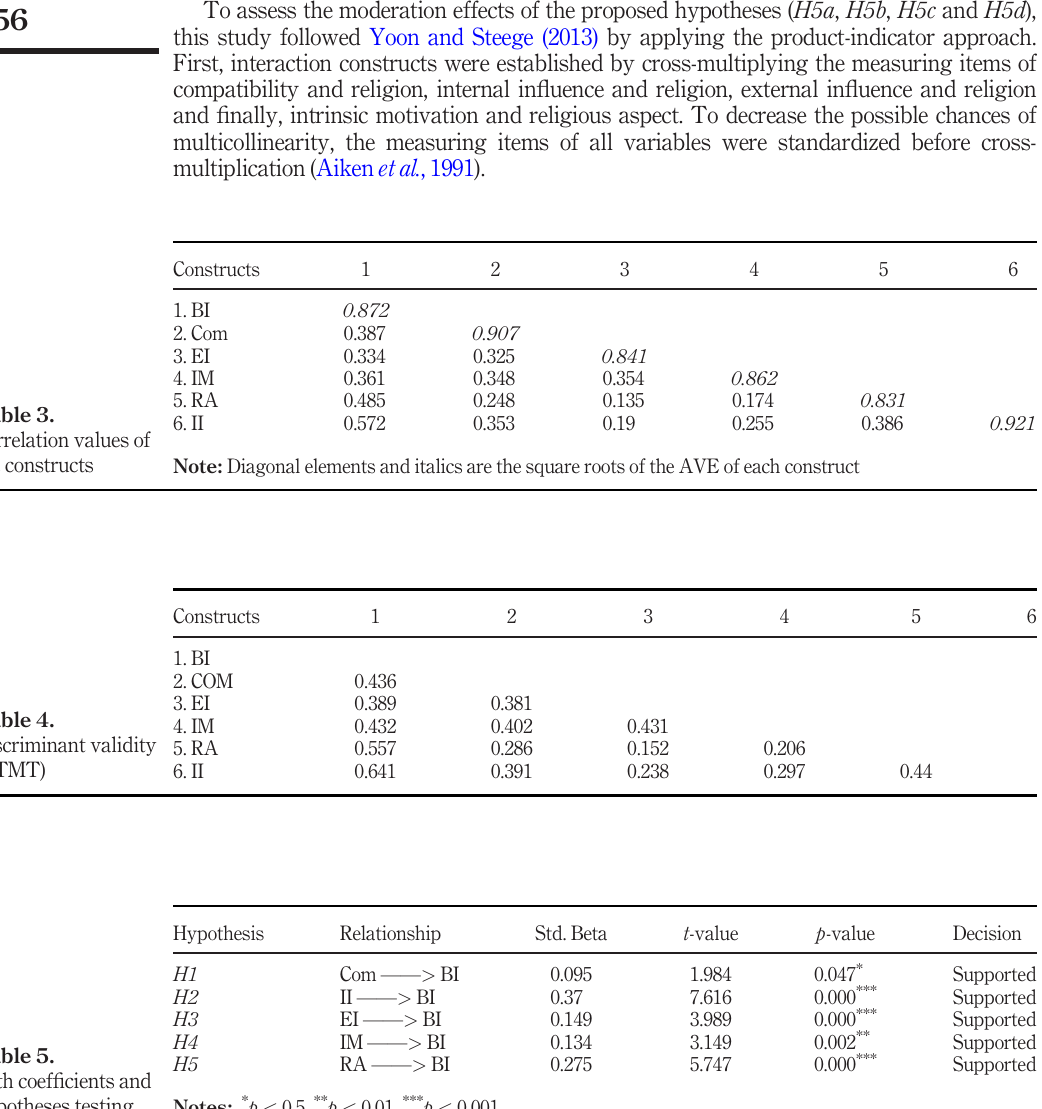
Table 5. Path coef fi cients and hypotheses